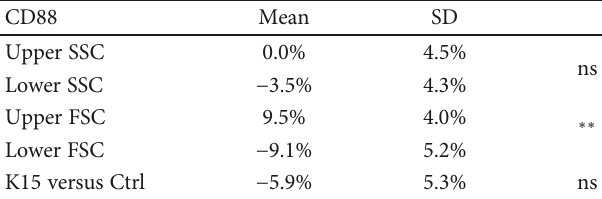
Table 1: Expression of CD88 on human